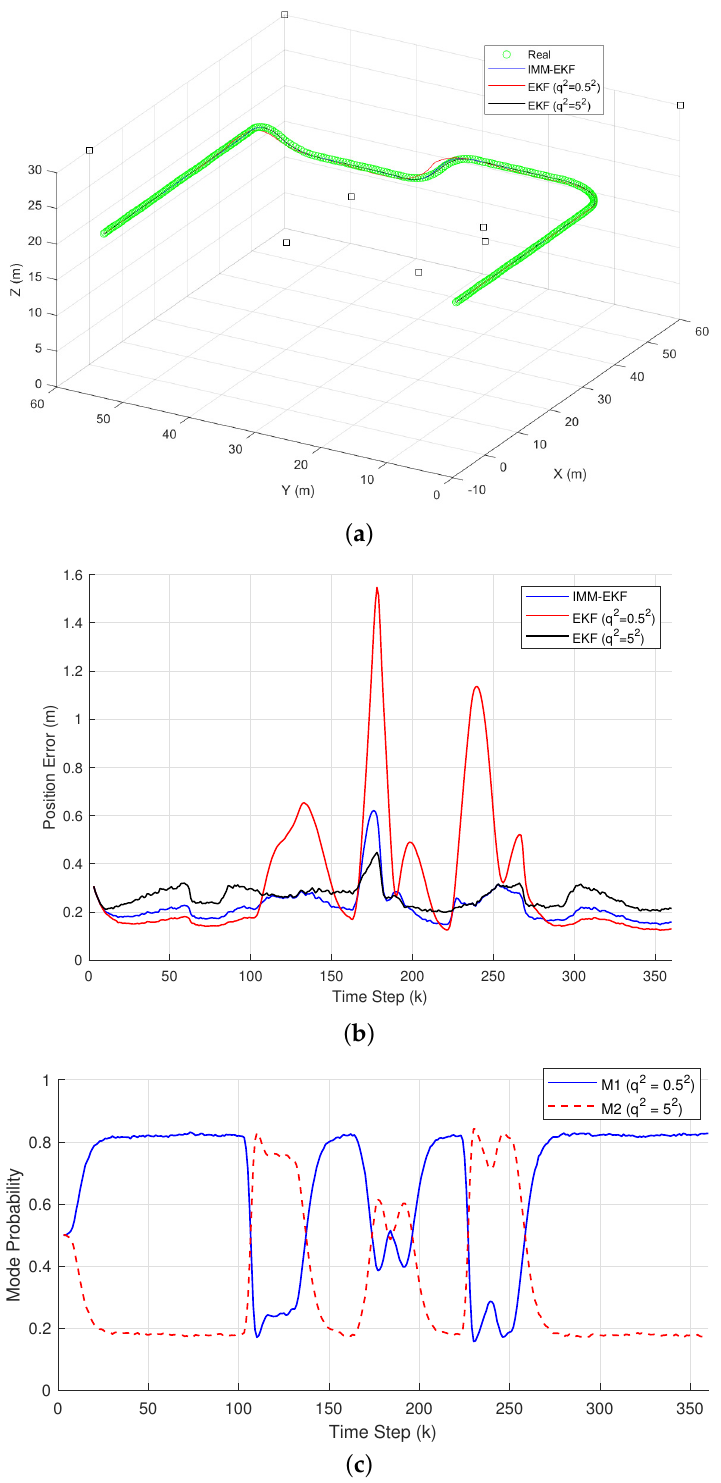
Figure 4. Results of 3D localization using EKF and IMM-EKF in LOS conditions: ( a ) trajectory of mobile node, ( b ) RMS position error and ( c ) mode probabilities of